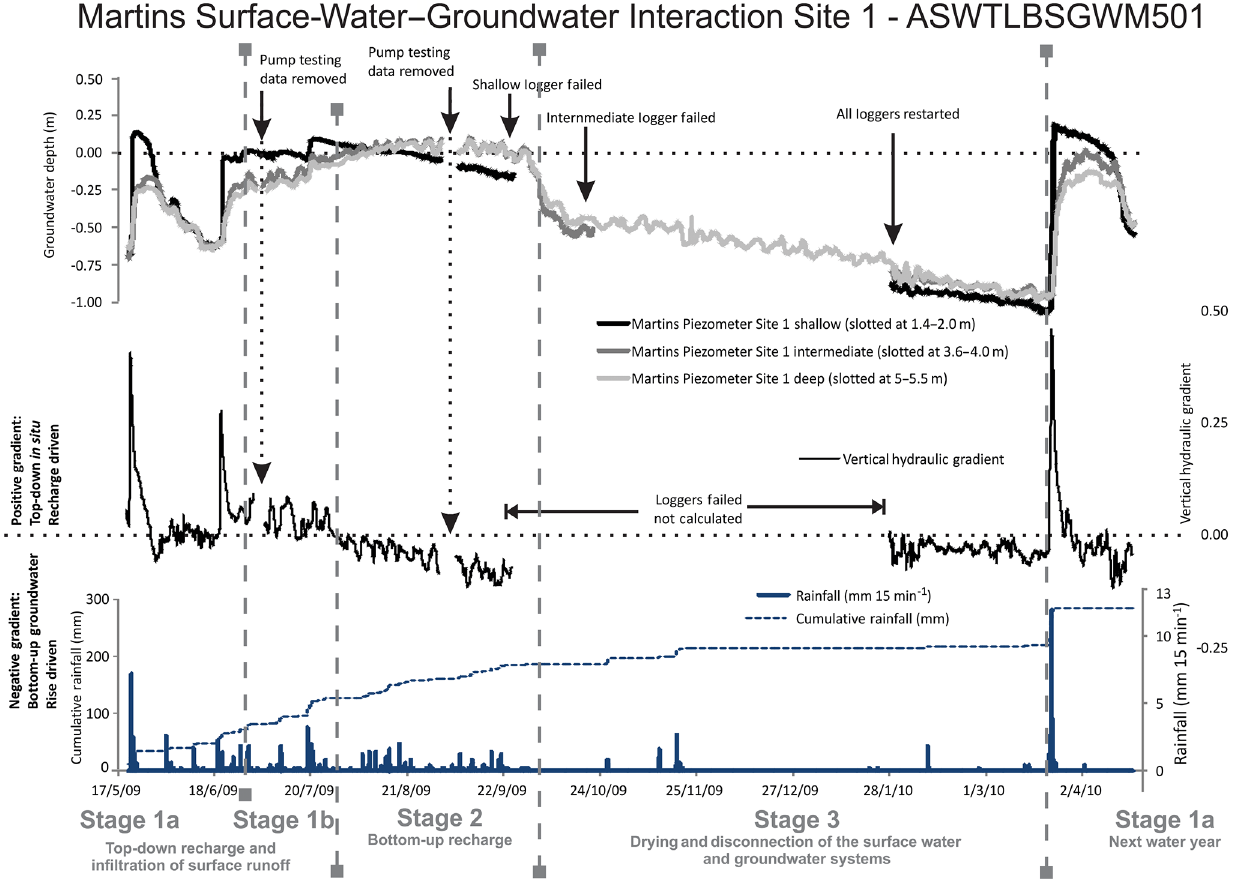
Figure 4. Groundwater data for Martins Site M1, showing the movement of the shallow, intermediate and deep piezometers and the overall vertical hydraulic gradient from May 2009 to June 2010 and three stages of SW–GW